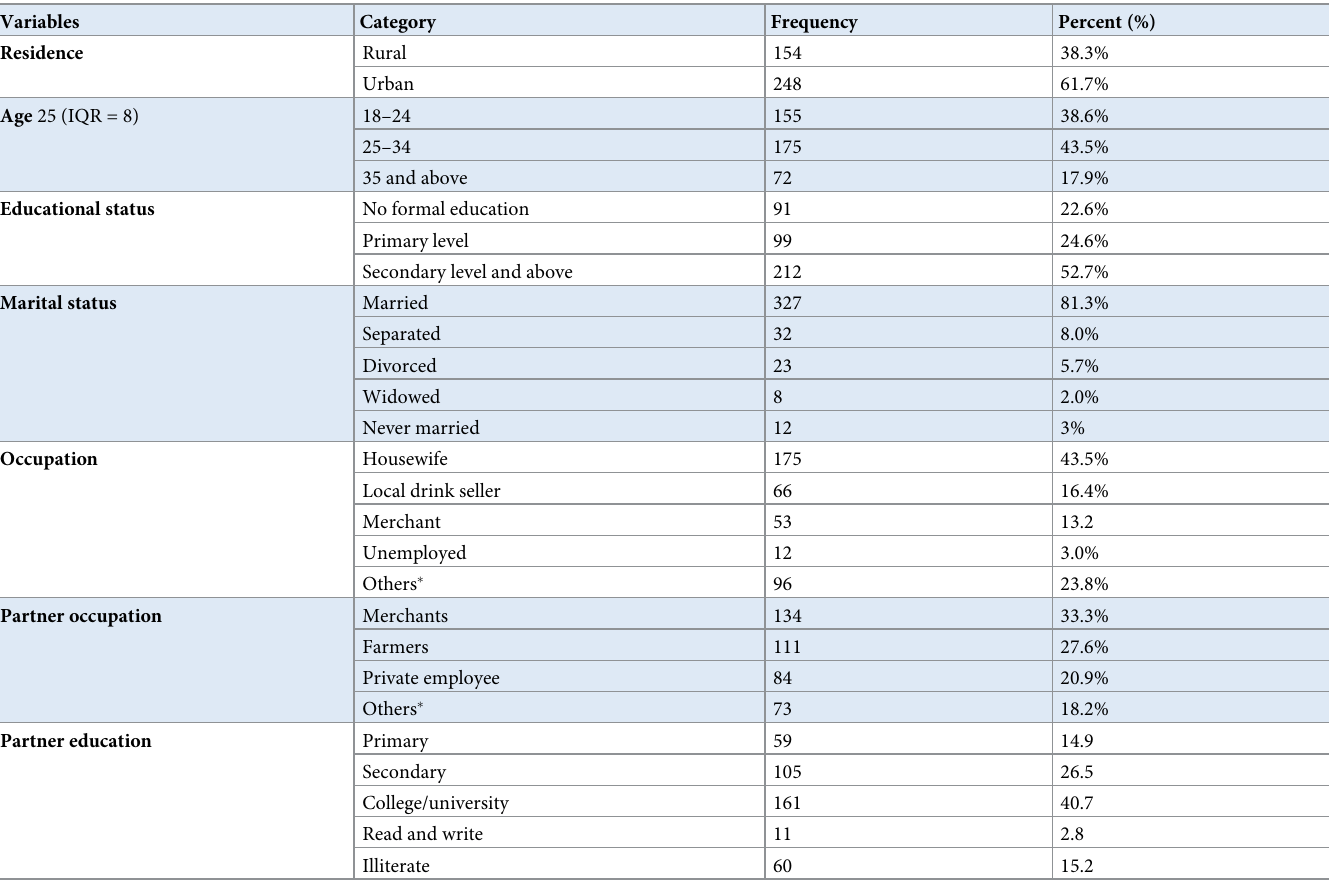
Table 2. Socio-demographic characteristics of pregnant women in Ilubabor zone, Southwest Ethiopia, February to April 2021 ( n =